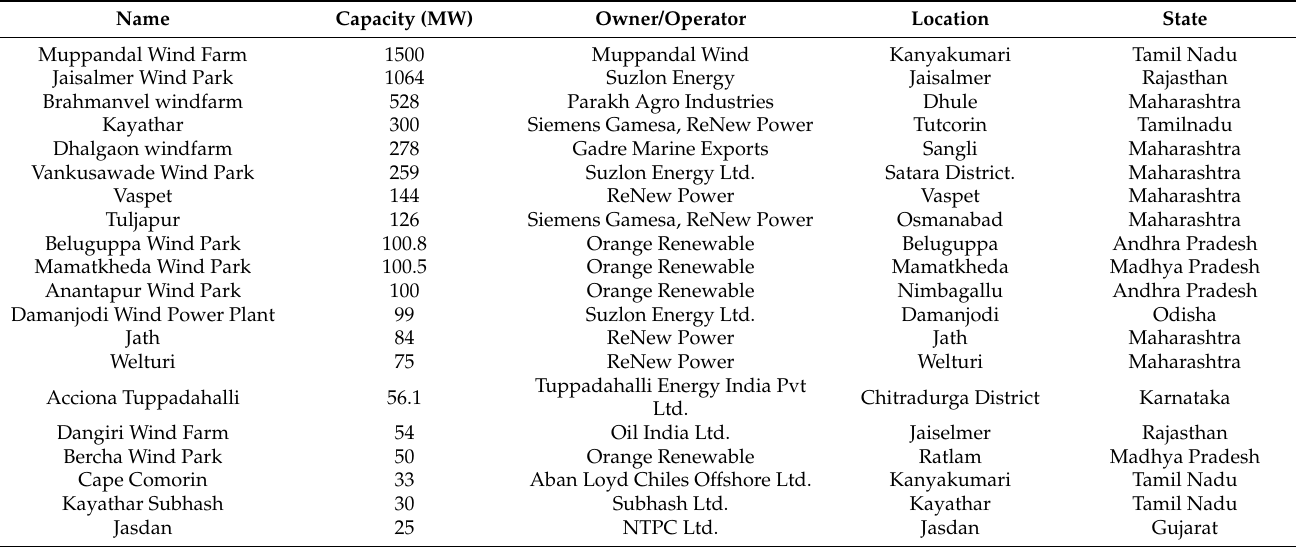
Table 20. Status of India’s largest onshore wind power plants (as on 28 February 2021). Source: Wind Power in India [73].